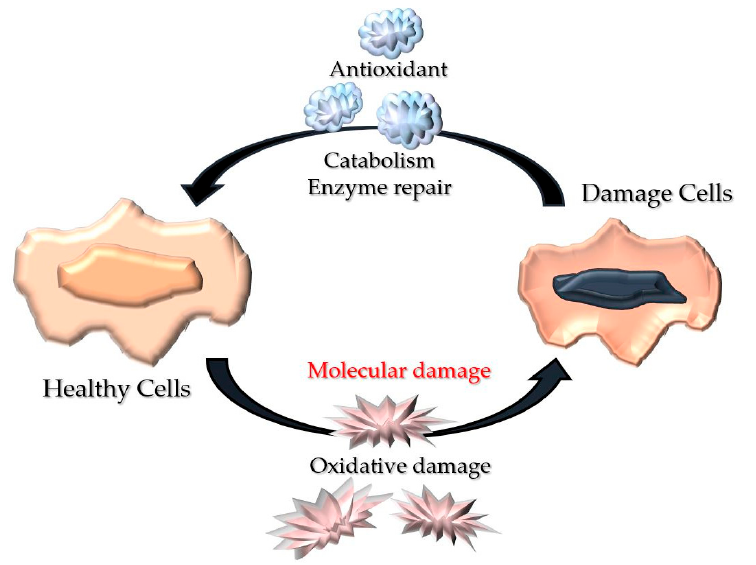
Figure 2. Representative illustration of wound oxidative stress. Healthy cells recuperate via metabolism amelioration and enzyme repair before oxidative mutilation to circumvent apoptosis or impairment.